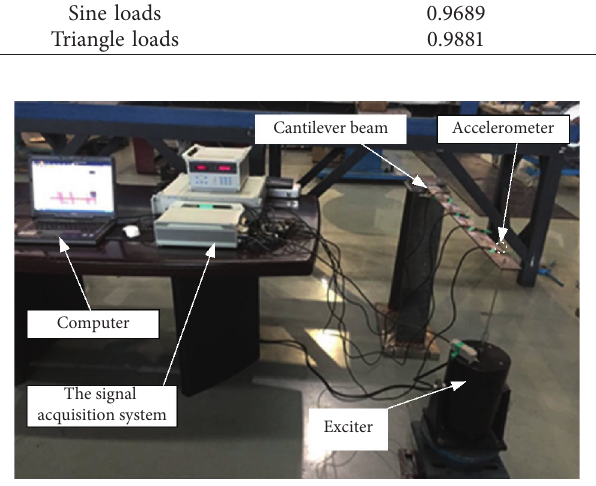
Figure 9: Field diagram of modal experiments of the cantilever beam. Table 4: Natural frequency comparison of beam structures and experimental